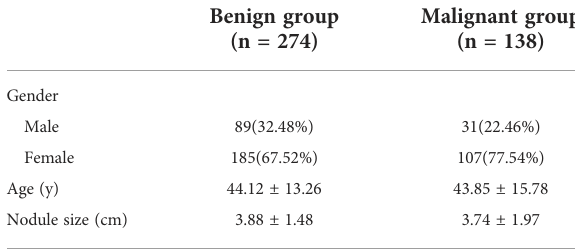
TABLE 1 Characteristics of study